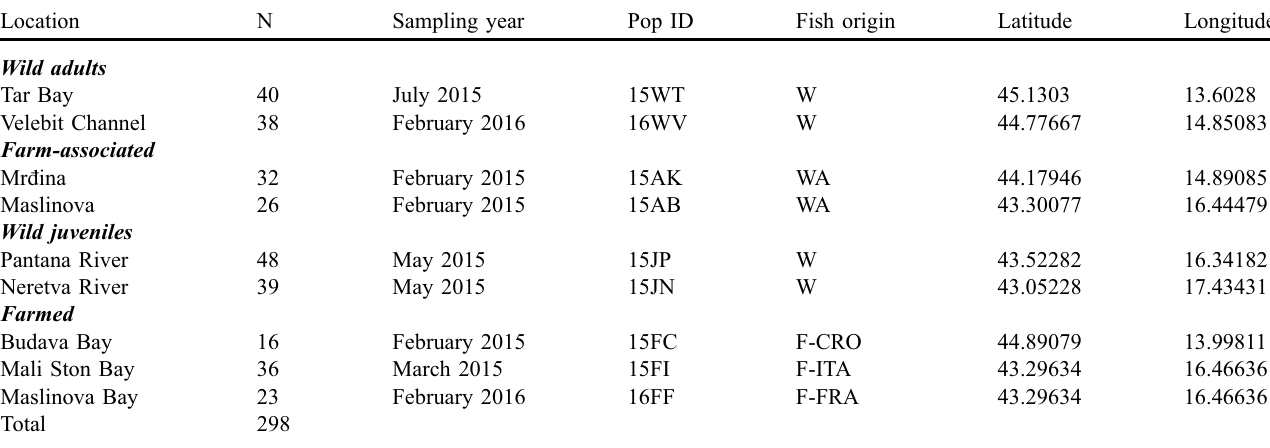
Tab. 1. Information of sampling locations, year and population code, along with the origin and number of individual gilthead seabream that were genetically assayed with 3 microsatellites linked to three candidate genes (cgSST).